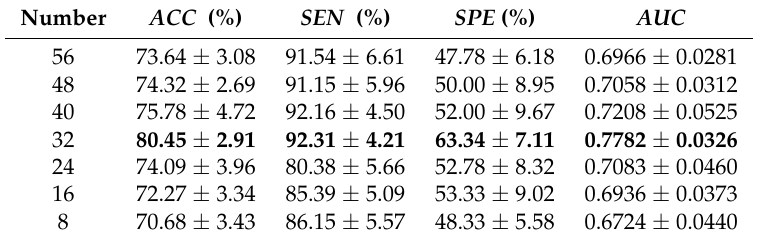
Table 9. Classification performance of 2D models with different numbers of 2D slices for T2 task.